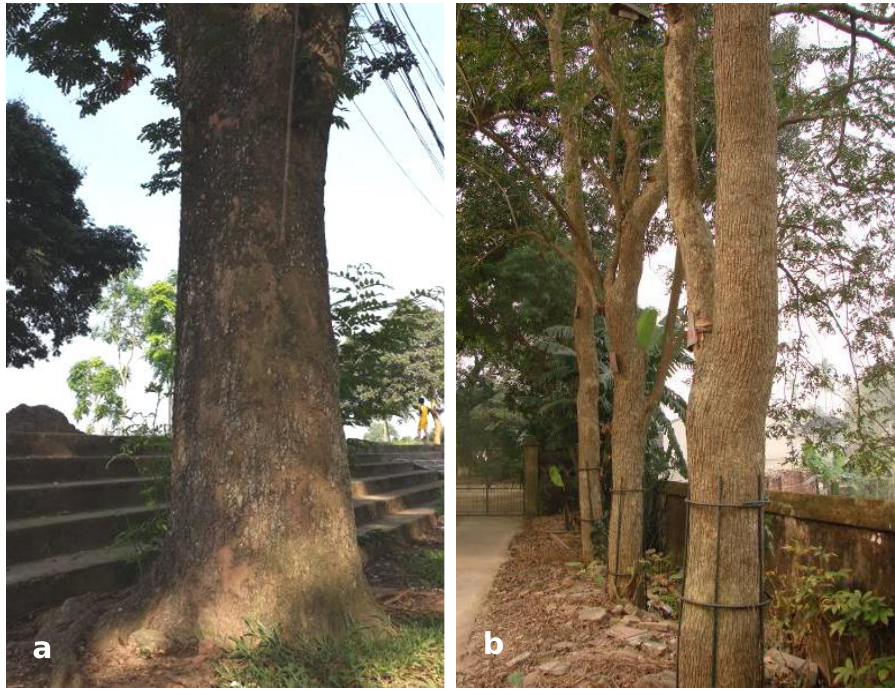
Figure 2. Examples of Dalbergia tonkinensis mother trees used for seed collection: ( a ) in the grounds of a Buddhist temple in Hanoi (Dbh = 70.2 cm, Ht = 25 m), ( b ) on the side of a roadway in Hung Yen (Dbh = 58.6 cm, Ht = 18 m).